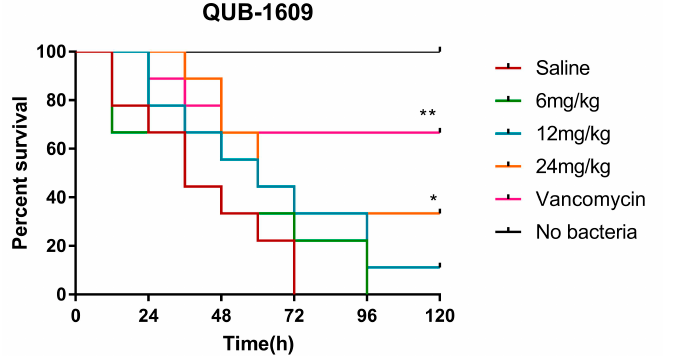
Figure 11. Treatment of S. aureus infected Galleria mellonella larvae by kassporin-KS1 (QUB-1641) analogues. Infected larvae were treated with peptides at 6, 12, and 24 mg/kg, respectively. The negative control was the saline injection to the larvae, and the positive control was the administration of 20 mg/kg Vancomycin. ‘*’ indicated Log-rank (Mantel–Cox) Test of each peptide sample group against the negative control: * p < 0.05, ** p < 0.01, *** p < 0.001, **** p <0.0001.